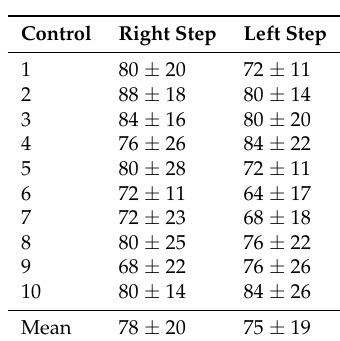
Table 2. Controls step exercise achievement rate (%). Mean ± standard deviation of 5 series of 5 repetitions per